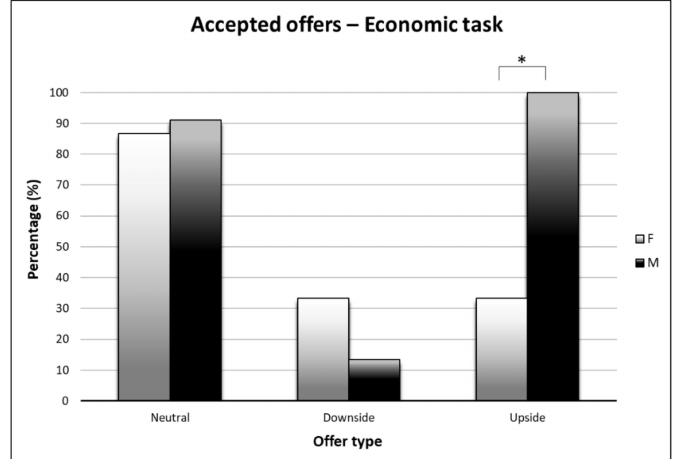
Figure 3. Percentage of accepted o ff ers by males and females for condition and o ff er type. Statistically significant comparisons are marked with an asterisk.